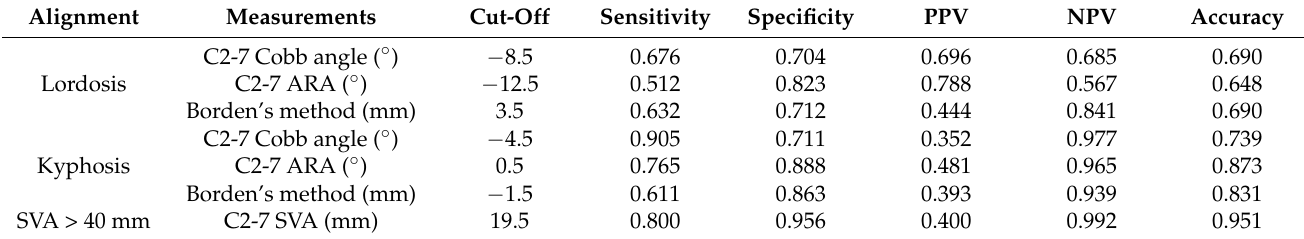
Table 3. Comparative diagnostic accuracy of the four measurements.